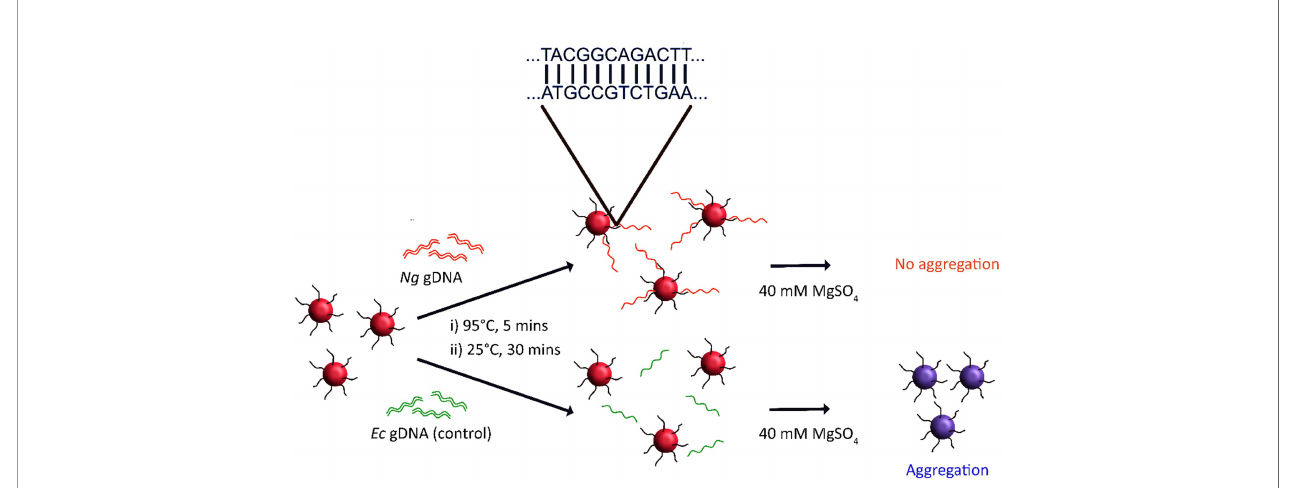
FIGURE 5 | Scheme for N. gonorrhoeae ( Ng ) DNA detection via salt-induced aggregation of gold nanoprobes. Here, DUS-functionalised nanoprobes are incubated with a test sample of DNA. If the DNA contains the reverse complement DUS then the nanoprobes may anneal to the DNA, producing a double-stranded DNA corona around the nanoprobes. This improves both the steric and electronic stabilisation of the nanoprobes such that they remain stable at higher salt concentrations than nanoprobes which have not been treated with target DNA. E. coli ( Ec ) DNA is used as a negative